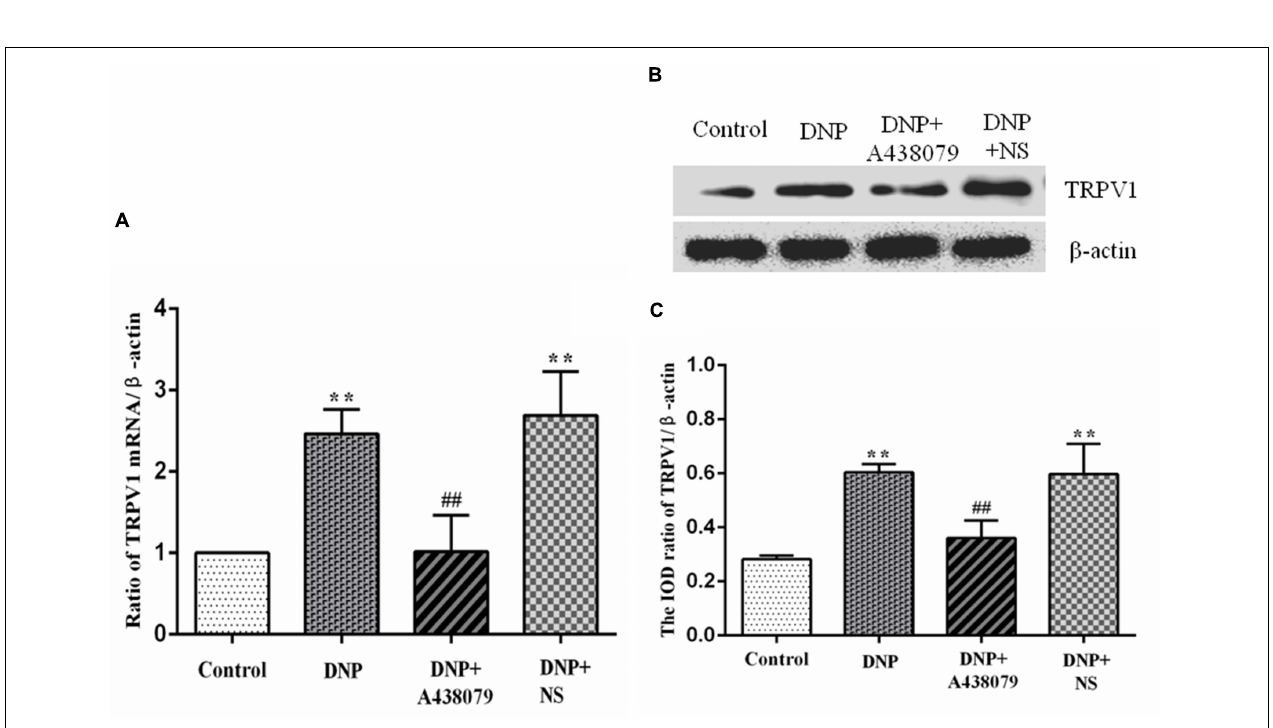
FIGURE 2 | The levels of the TRPV1 mRNA and protein in the DRG were detected. (A) The level of the TRPV1 mRNA in the DRG from each group. (B) SDS-PAGE band of the TRPV1 protein in the DRG from each group of experimental rats. (C) Analysis of the relative level of the TRPV1 protein in the DRG from each group of experimental rats. Higher levels of the TRPV1 mRNA and protein were detected in the DRG in the DNP group than in the control group, while lower levels of the TRPV1 mRNA and protein were observed in the DRG in the DNP + A438079 group than in the DNP group. The data are presented as the mean ± SEM, n = 6; compared with the control group, ** P < 0.01; compared with the DNP group, ## P < 0.01.